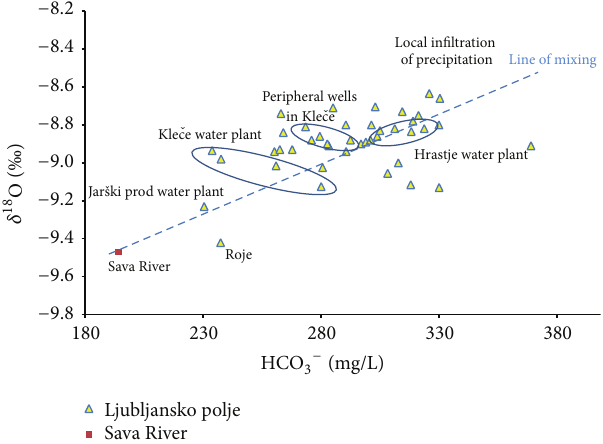
Figure 6: Relationship between HCO 3− and isotopic composition of oxygen ( 𝛿 18 O) in groundwater of Ljubljansko polje and line of mixing of groundwaters of different